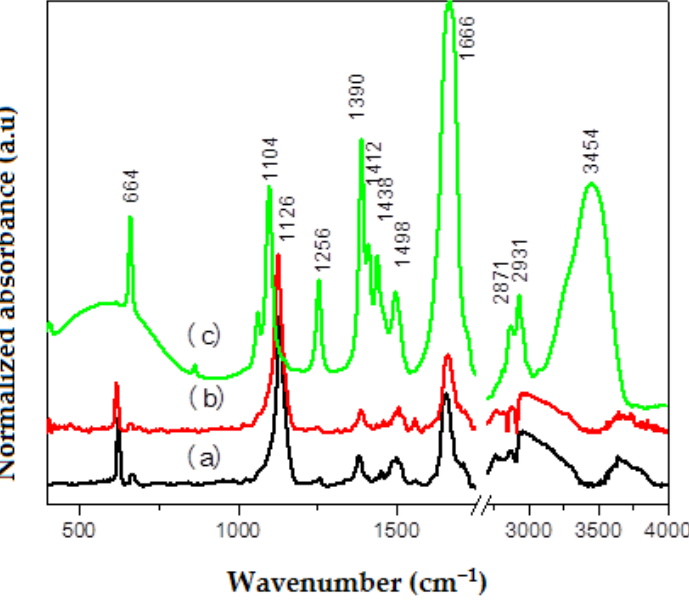
Figure 7. FTIR spectra of PANI ( a ), doped PANI ( b ) and Doped PANI/SWCNTs ( c ). To provide additional information on the functionalization process between D-PANI and SWCNTs, we present, in Figure 8, DSC thermograms of either doped PANI, SWCNTs or the resulting nano-composite.